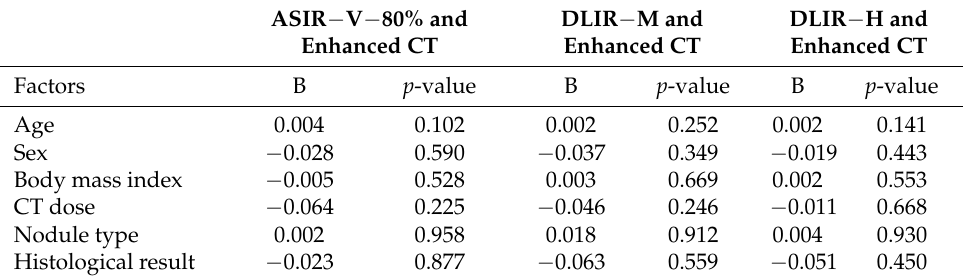
Table 7. Multiple linear regression analysis of influential factors on measurement difference of nonmeasurable pulmonary lesions between ultra-low-dose CT and contrast-enhanced CT.